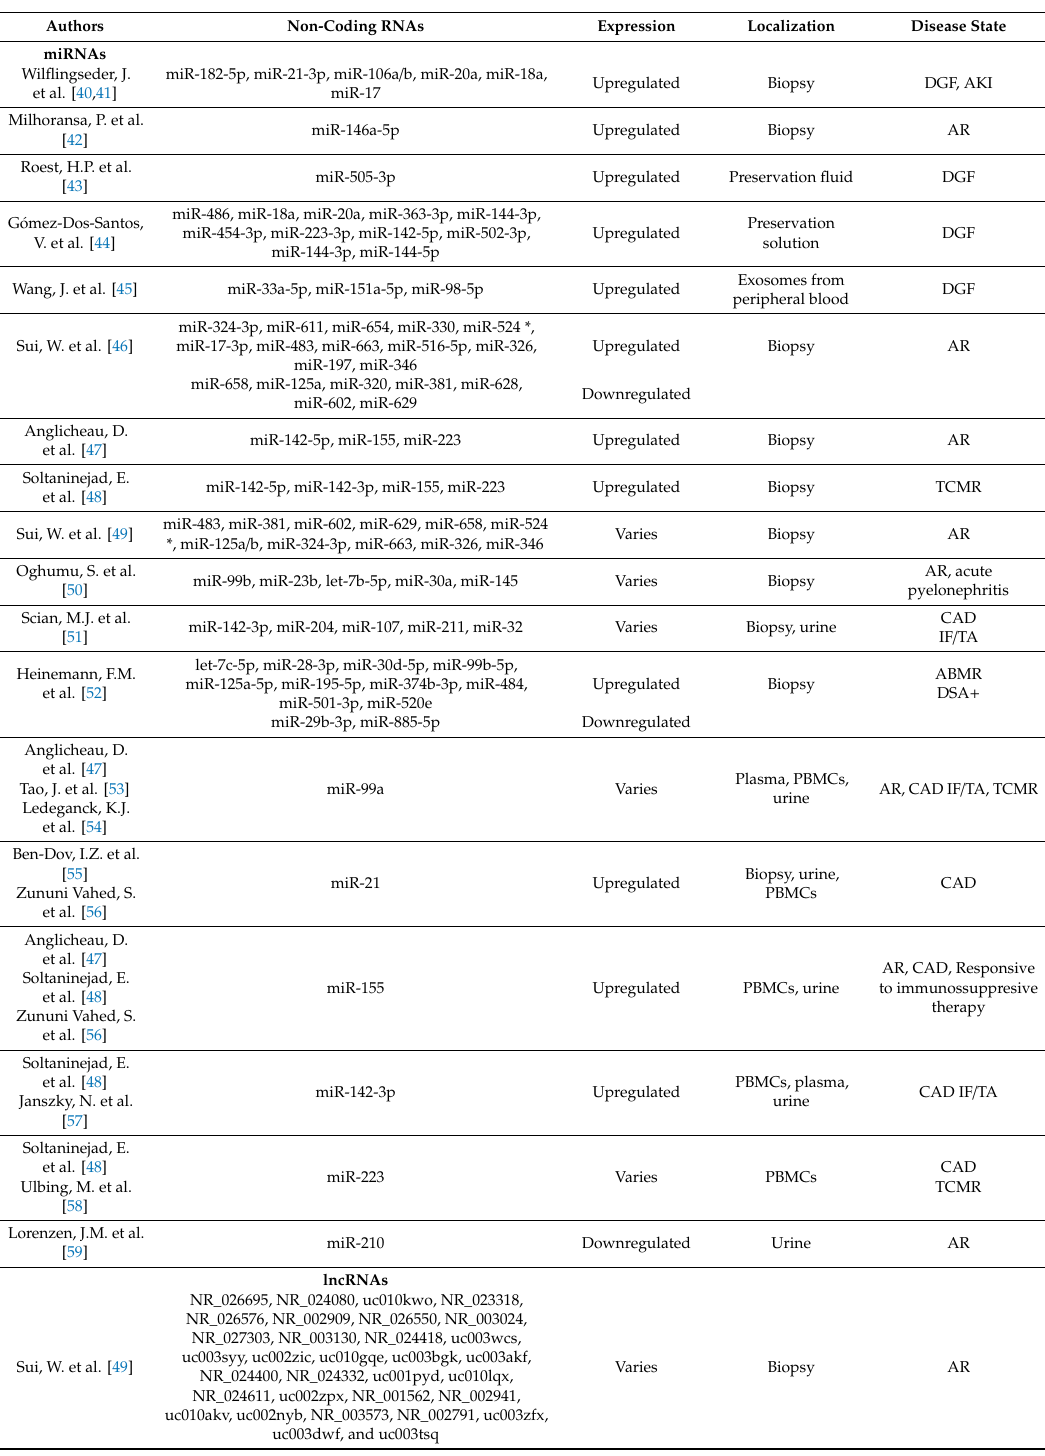
Table 1. Expression of ncRNAs (non-coding RNAs) associated with disease states post-transplantation.